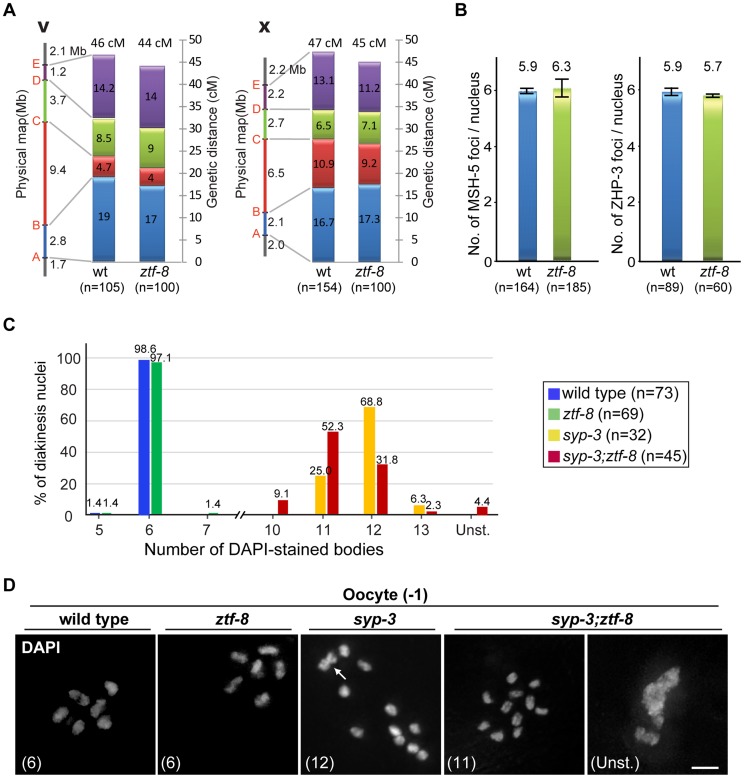
ZTF-8 is not required for the regulation of either crossover frequency or distribution.
A. Analysis of crossover frequency and distribution for chromosomes V and X in wild type and ztf-8 mutants. Positions of SNP markers delimiting four intervals (A–B, B–C, C–D, and D–E) are indicated. n = number of cross progeny scored. B. Quantitation of the number of MSH-5 and ZHP-3 foci observed in meiotic nuclei from ztf-8 mutants compared to wild type. MSH-5 foci, P = 0.2139, n = 164 for wt and n = 185 for ztf-8. ZHP-3 foci, P = 0.2505, n = 89 for wt and n = 60 for ztf-8. C. Number of DAPI-stained bodies observed in diakinesis oocytes from the indicated genotypes. The number of −1 oocytes scored (n) is indicated next to the genotypes. Unst., nuclei with unstructured chromatin. D. Representative images of DAPI-stained nuclei in −1 oocytes at diakinesis from the indicated genotypes. The number in parenthesis in each image represents the total number of DAPI-stained bodies scored for that nucleus. Unst., nuclei with unstructured chromatin. Arrow indicates two superimposed univalents in the syp-3(ok758) diakinesis oocyte.